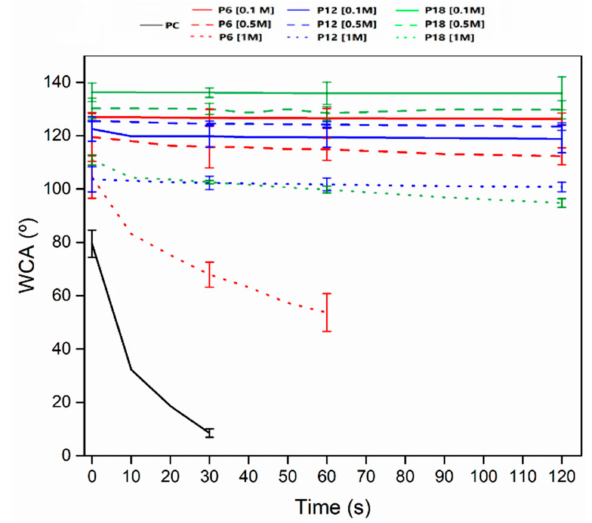
Figure 2. Dynamic contact angle untreated and esterified